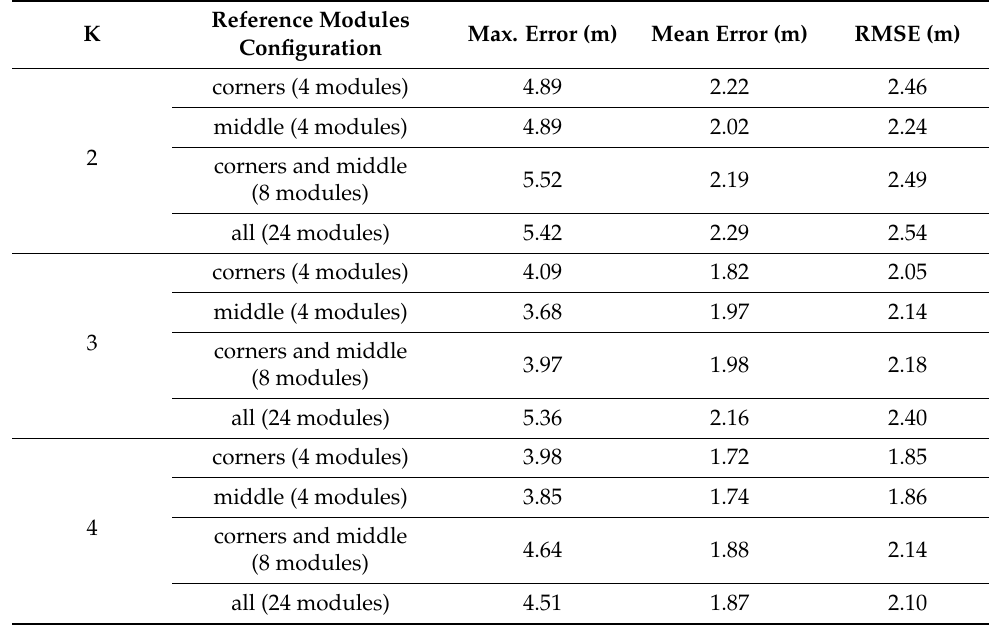
Table 3. Estimation accuracy of the proposed localization algorithm, including the maximum error, mean value, and root mean square error (RMSE) calculated for various limited layouts of reference